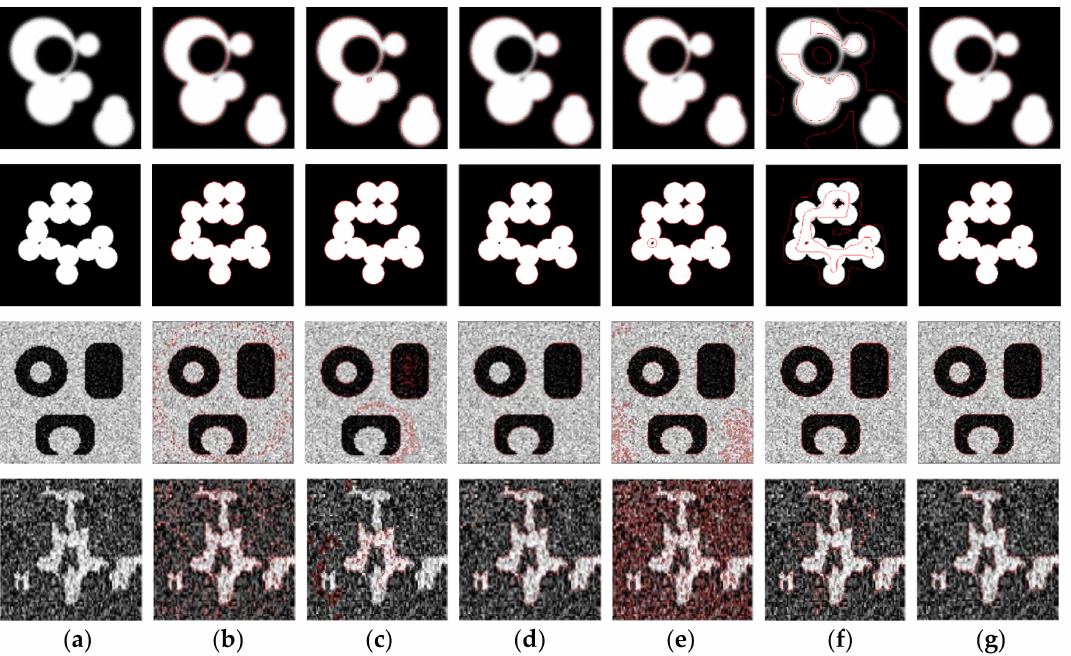
Figure 3. The segmentation results of the multiobjective images for the six models. ( a ) Original image, ( b ) C–V model, ( c ) LBF model, ( d ) SBGFRLS model, ( e ) LIF model, ( f ) LSACM model, and ( g ) SPFLIF-IS model.